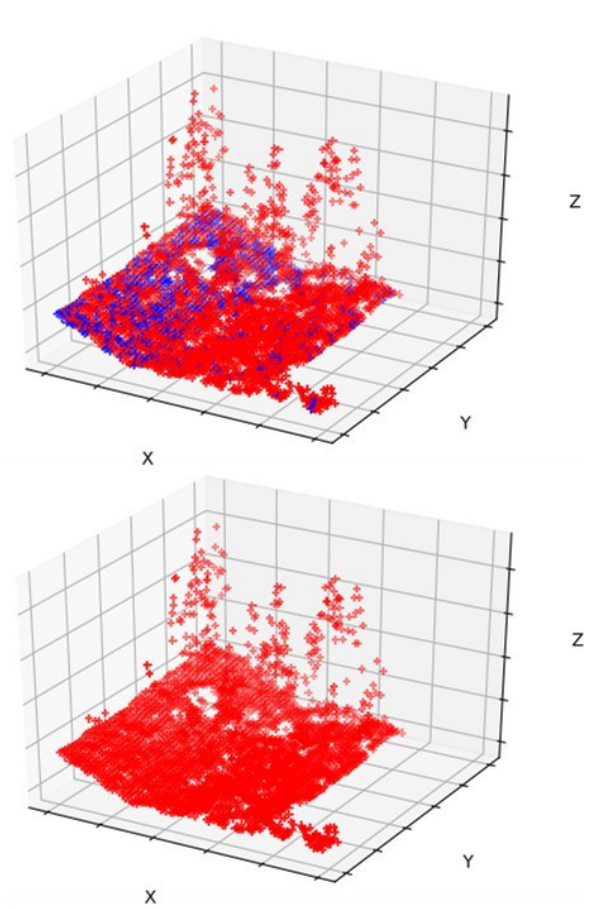
Figure 5: Comparison between reference points (above) and clas- sified points (below). Blue represents ground